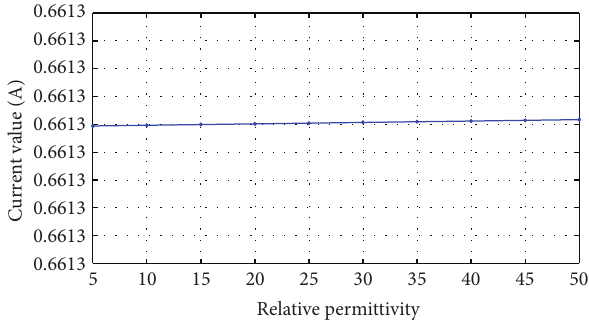
Figure 16: Curve of the maximum current value with the relative permittivity.